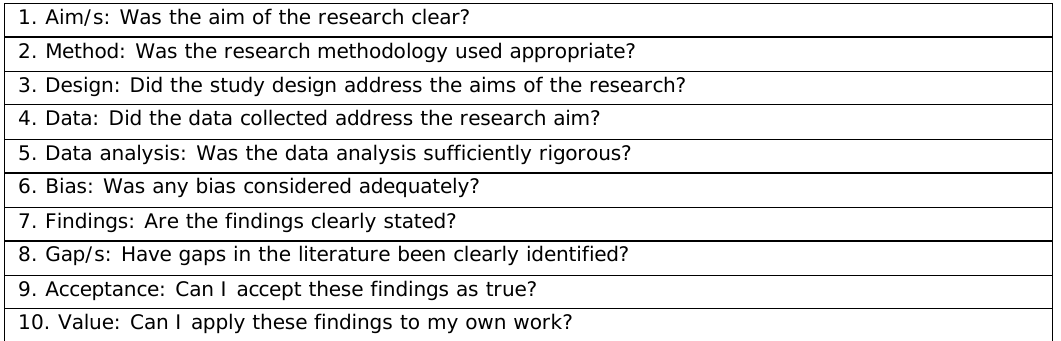
Table 2. Modified Critical Appraisal Skills Program